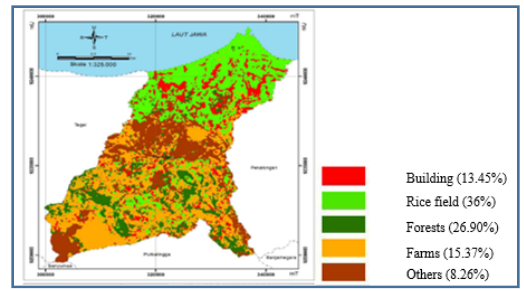
Figure 5. Land use in Pemalang, Central Java (The regional development planning agency, the regency of Pemalang.